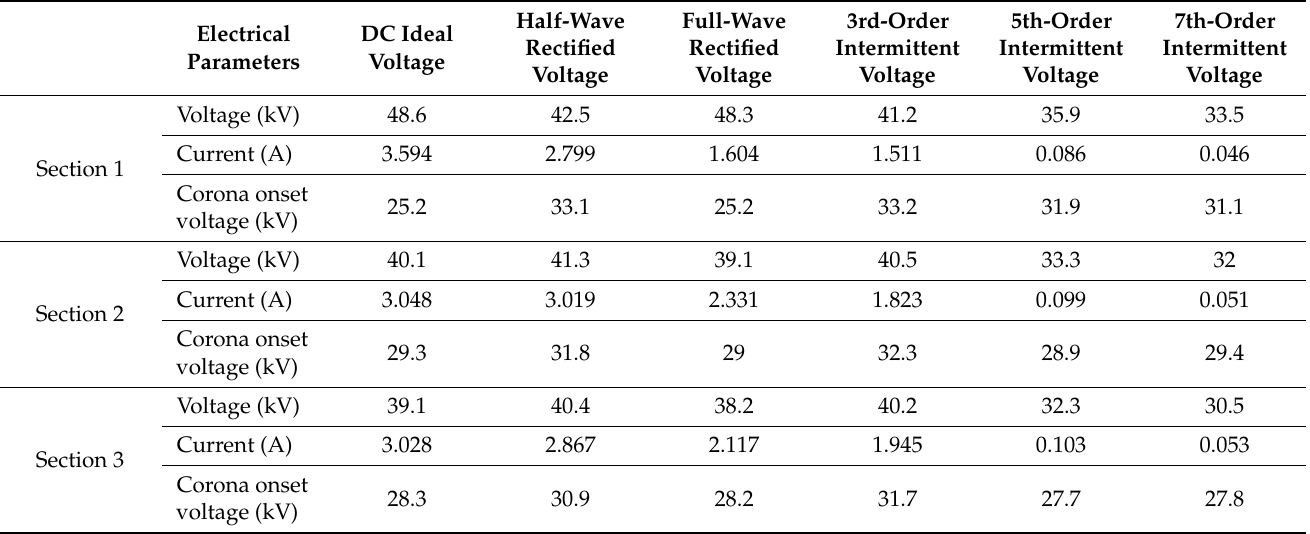
Table 7. Electrical parameters on the sections, without dust on the collector surfaces, for different types of supply voltages, dust resistivity 10 12 Ω ×